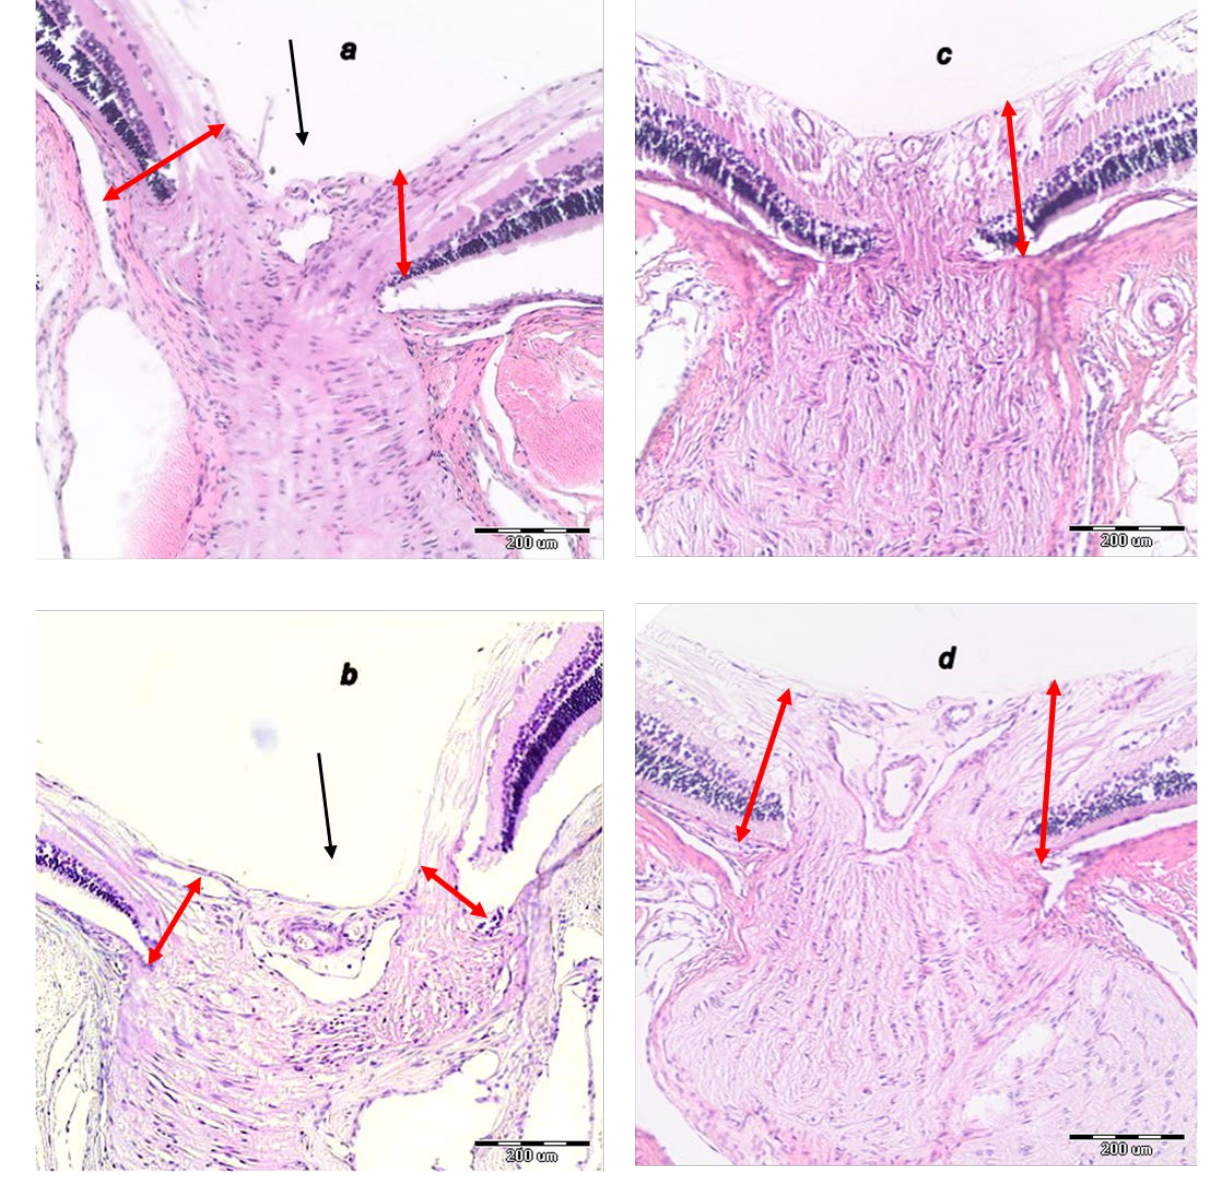
Figure 14. Histopathology of the optic nerve head. ( a ) Optic nerve head of rat retina after episcleral vein cauterization at week 4 in controls. ( b ) Optic nerve head of rat retina after episcleral vein cauterization at week 4 in controls. ( c ) Optic nerve head of rat retina after episcleral vein cauterization at week 4 in BPC 157-treated rats. ( d ) Optic nerve head of rat retina after episcleral vein cauterization at week 6 in BPC 157-treated rats. Optic nerve head excavation (black arrow) and thickness of anterior prelaminar region (double red arrow); HE staining, magnification 20 × , scale bar 200 µ m). Transverse section in the center of the optic nerve head showing a strict difference in the optic nerve head and optic nerve in the rats that received saline and those that received BPC 157. Optic nerve head in rats that received BPC 157 at week 4 ( c ) presented as not excavated, while optic nerve thickness and optic nerve head of anterior prelaminar region were preserved. On the contrary, in rats that received saline, at week 4 ( a ) optic nerve head excavation was present, while optic nerve and optic nerve head of anterior prelaminar region thickness was reduced. In rats that received BPC 157 at week 6 ( d ), optic nerve head excavation was not excavated at all, and optic nerve thickness was preserved. In rats that received saline at week 6 ( b ), optic nerve head excavation and reduction in optic nerve thickness was more pronounced. A similar effect was noted with all BPC 157 regimens. A total of 6